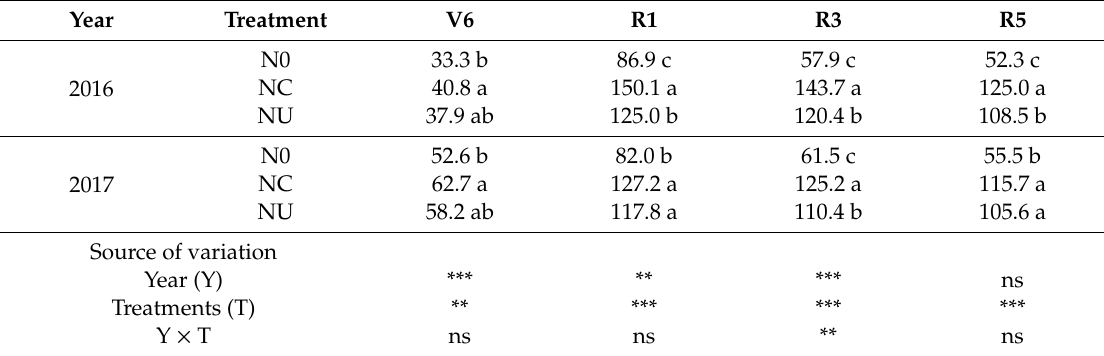
Table 2. Effects of N application treatments on total root weight density (g m − 3 ) in 0–60 cm (at V6 stage) and 0–100 cm (at R1, R3, and R5 stages) soil layers during the entire growing season in 2016 and 2017.